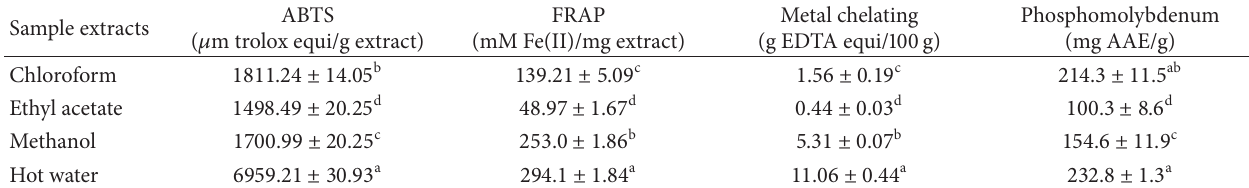
Values are mean of triplicate determination ( 𝑛 = 3 ) standard deviation. EDTA: ethylene diamine tetraacetic acid; AAE: ascorbic acid equivalence. Values followed by superscript indicate statistical significance 𝑃 < 0.05 .